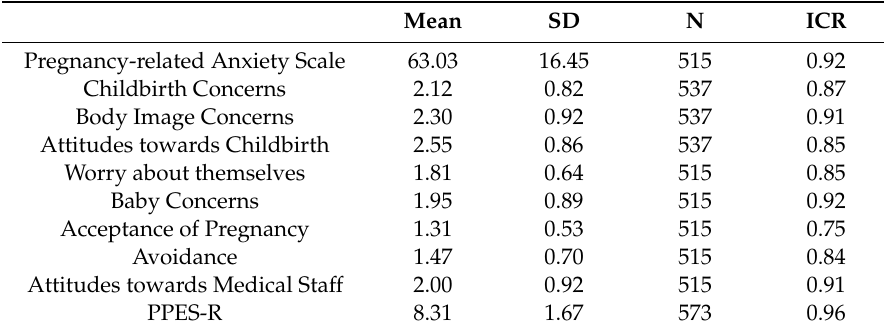
Table 2. Descriptive statistics for scales and